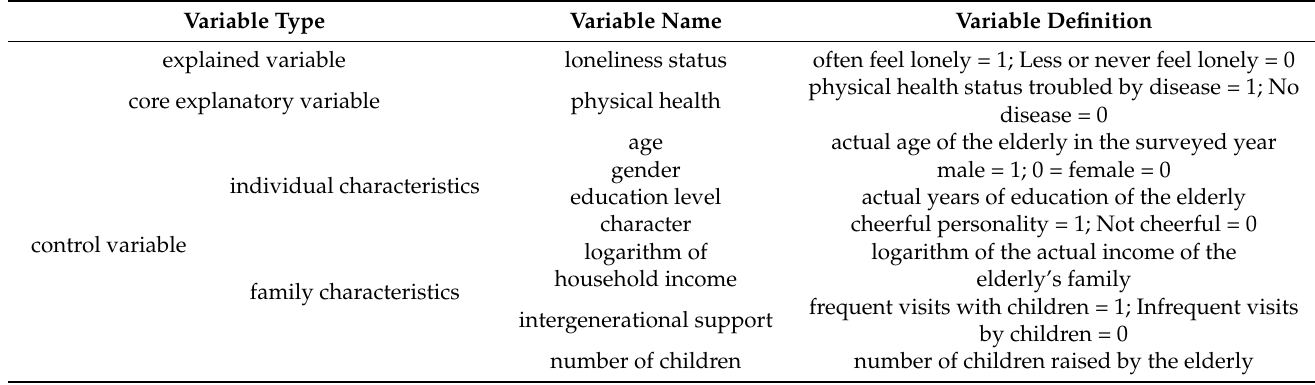
Table 1. Variable definition and